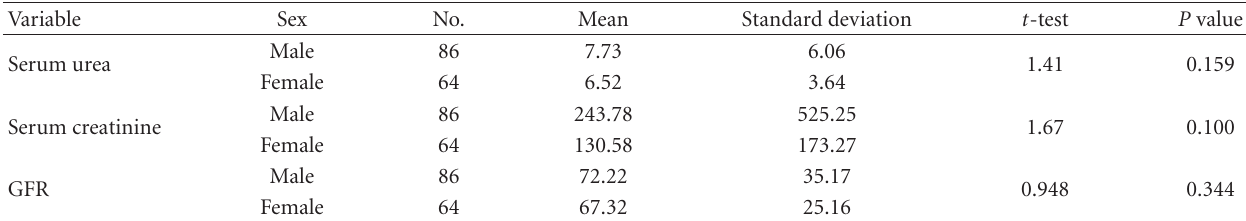
Table 2: Comparison of renal function indices of males and females.